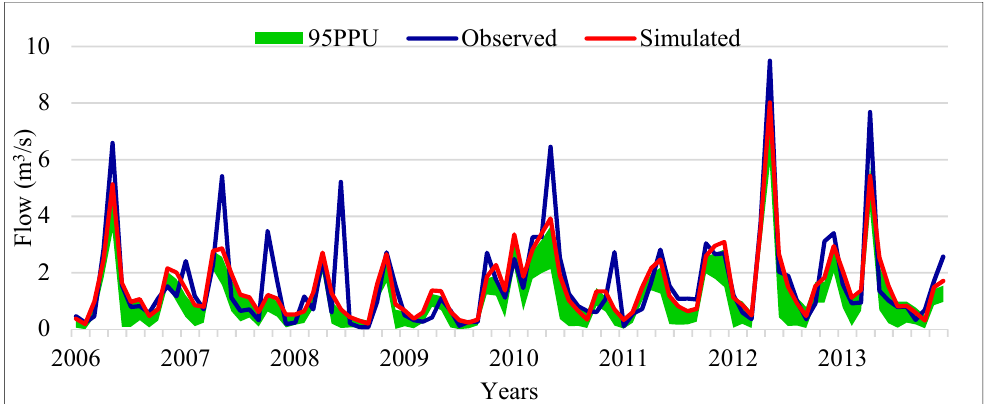
Figure 5. Monthly streamflow validation results for gauging station 4CB05.